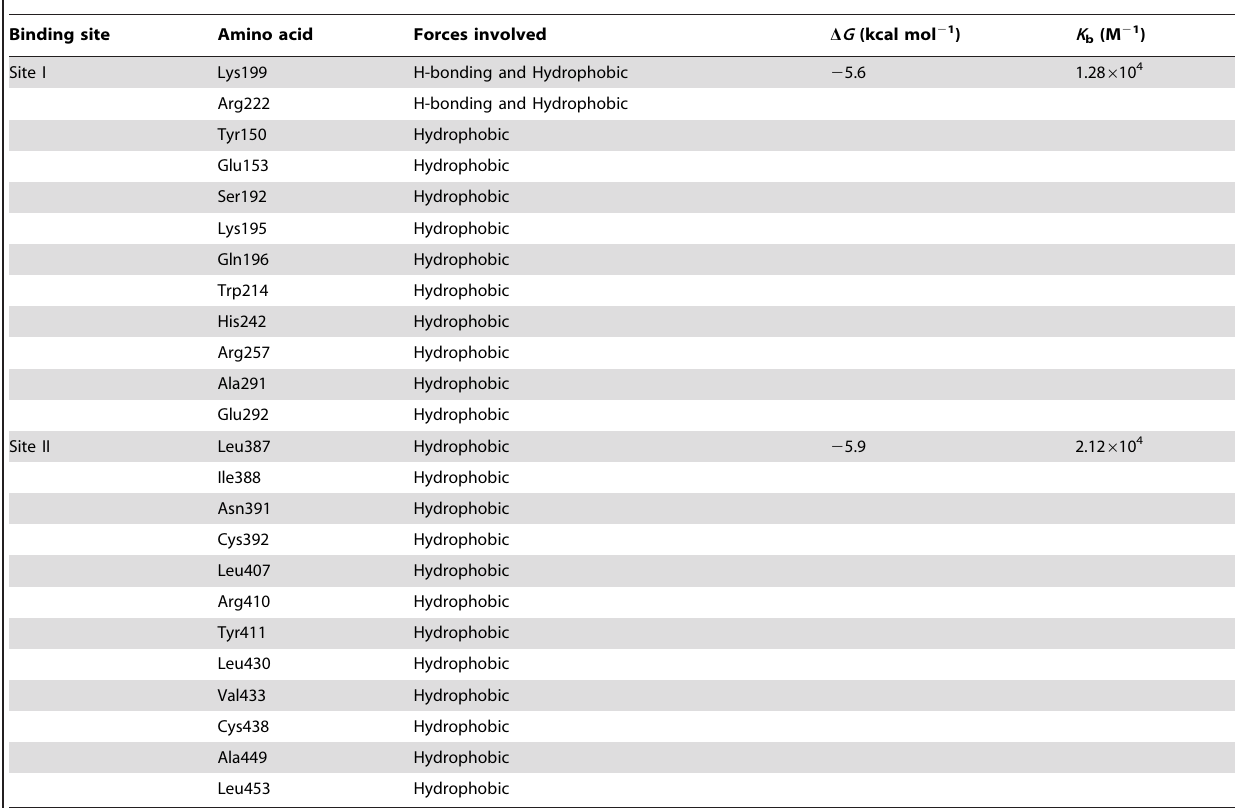
Table 5. Molecular docking results of HSA-HA interaction.